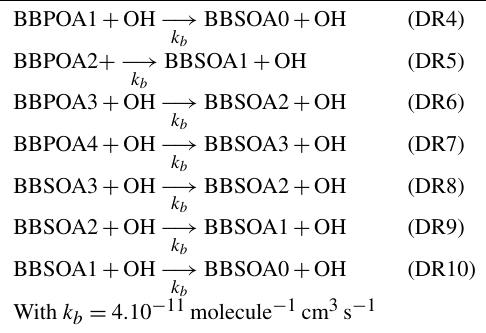
Table D1. Ageing mechanism of I/S/L-VOCs using Ciarelli approach (Ciarelli et al., 2017).